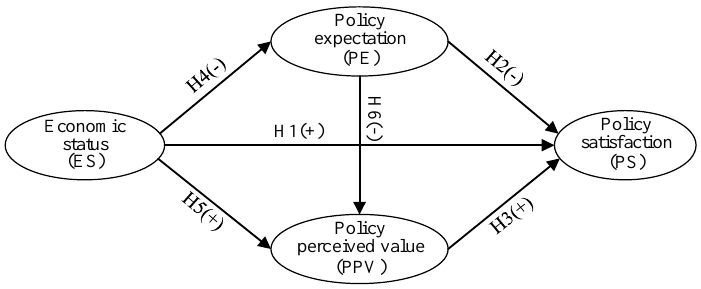
Figure 1. Theoretical framework: Study and hypotheses.